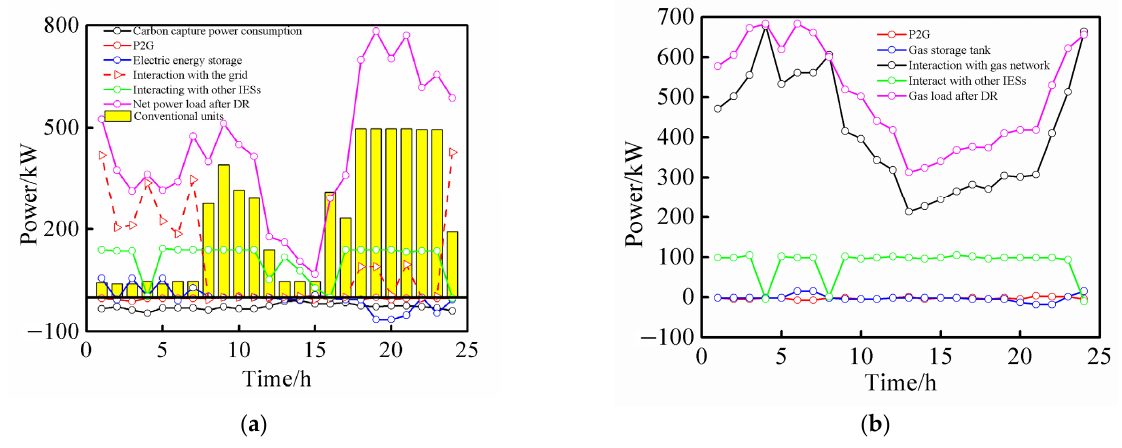
Figure 7. Balance diagram of Subsystem 1 under Scenario 4. ( a ) Electricity balance. ( b ) Gas balance.